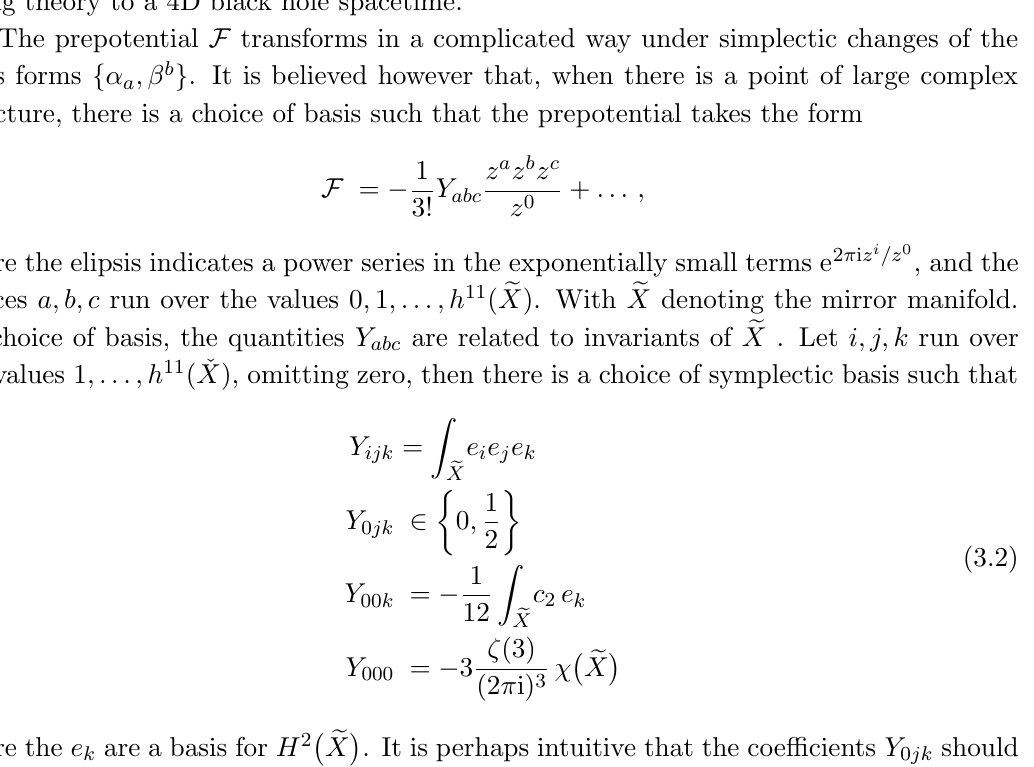
Figure 8 . The functions f j , and so the periods, are de(cid:12)ned initially in a disk of radius 1 is a branch cut on the negative real axis owing to our convention for the de(cid:12)nition of the logarithm. The branch cut that runs out along the positive real axis from ’ = 1 of the functions f j . The two red dots indicate the attractor points at ’ = (cid:0) 1 large complex structure limit is at ’ = 0, and is marked by a hollow dot, and the black dots indicate (hyper) conifold points. The attractor point at ’ = ’ + and the conifold point at ’ = 1 are not